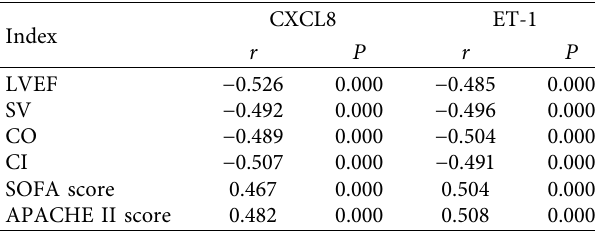
Figure 2: Correlation between serum CXCL8 and ET-1 in sepsis patients complicated with heart failure. Table 4: Correlation between expression levels of serum CXCL8 and ET-1 in sepsis patients complicated with heart failure and clinical data and cardiac function parameters.